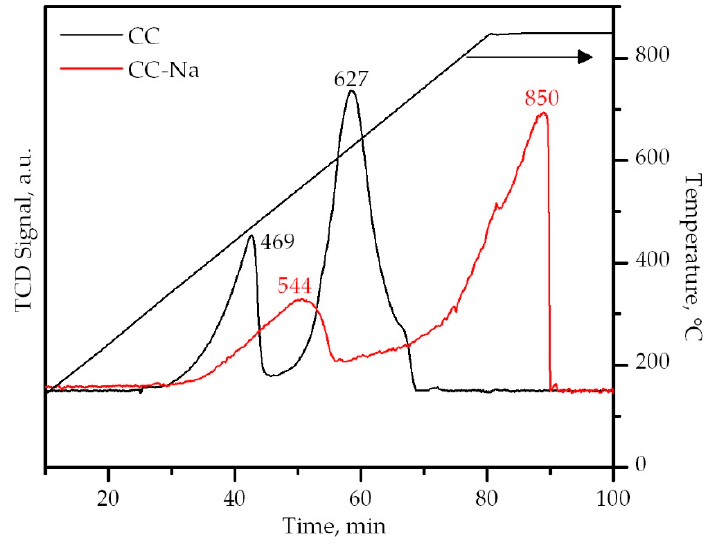
Figure 8. CH 4 -TPRe profiles of the samples.